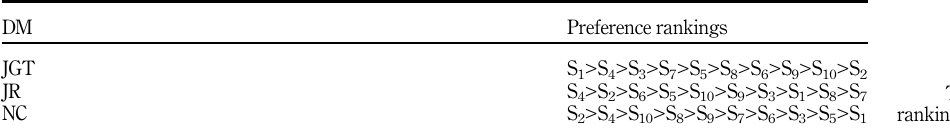
Table 2. The preference rankings of each